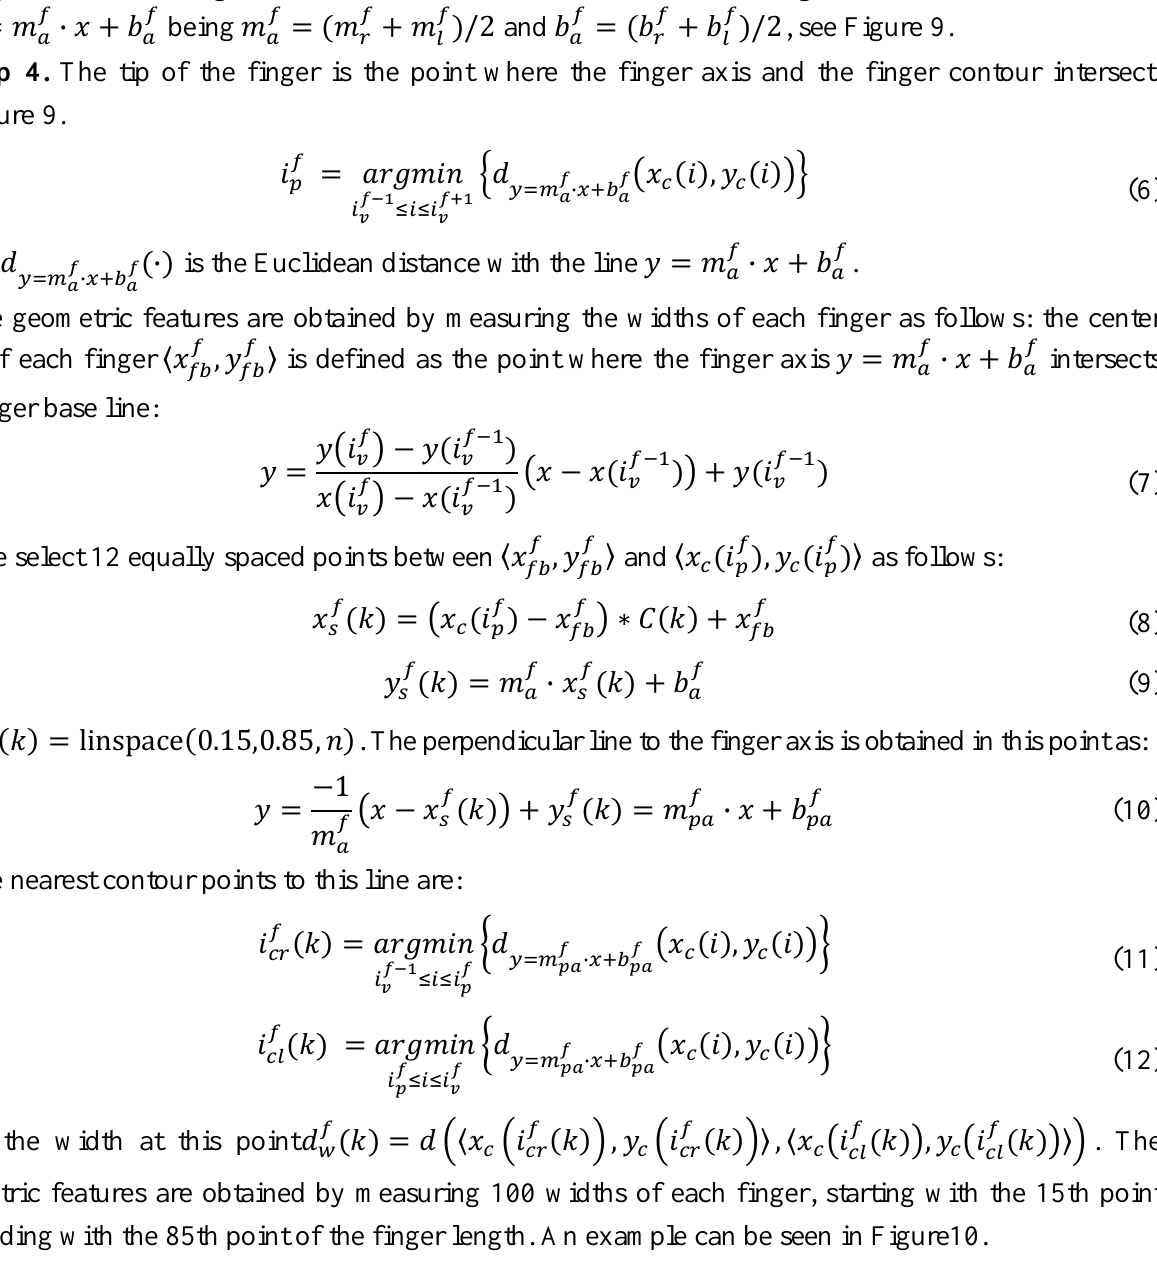
Figure 10. Finger widths measured for the geometrical